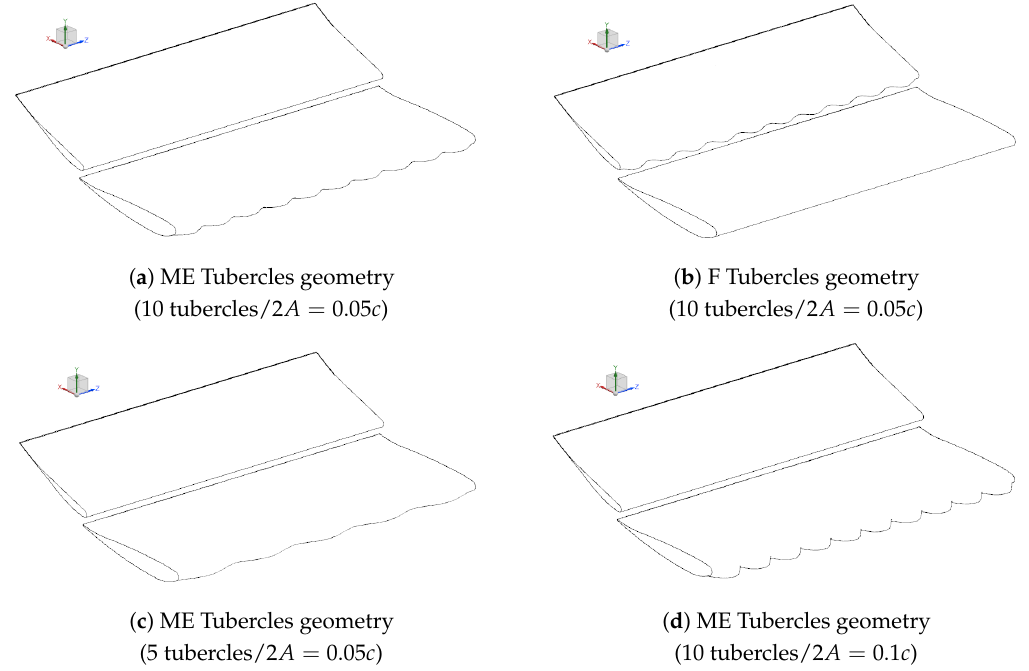
Figure 7. All geometries with tubercles from Steps 1 and